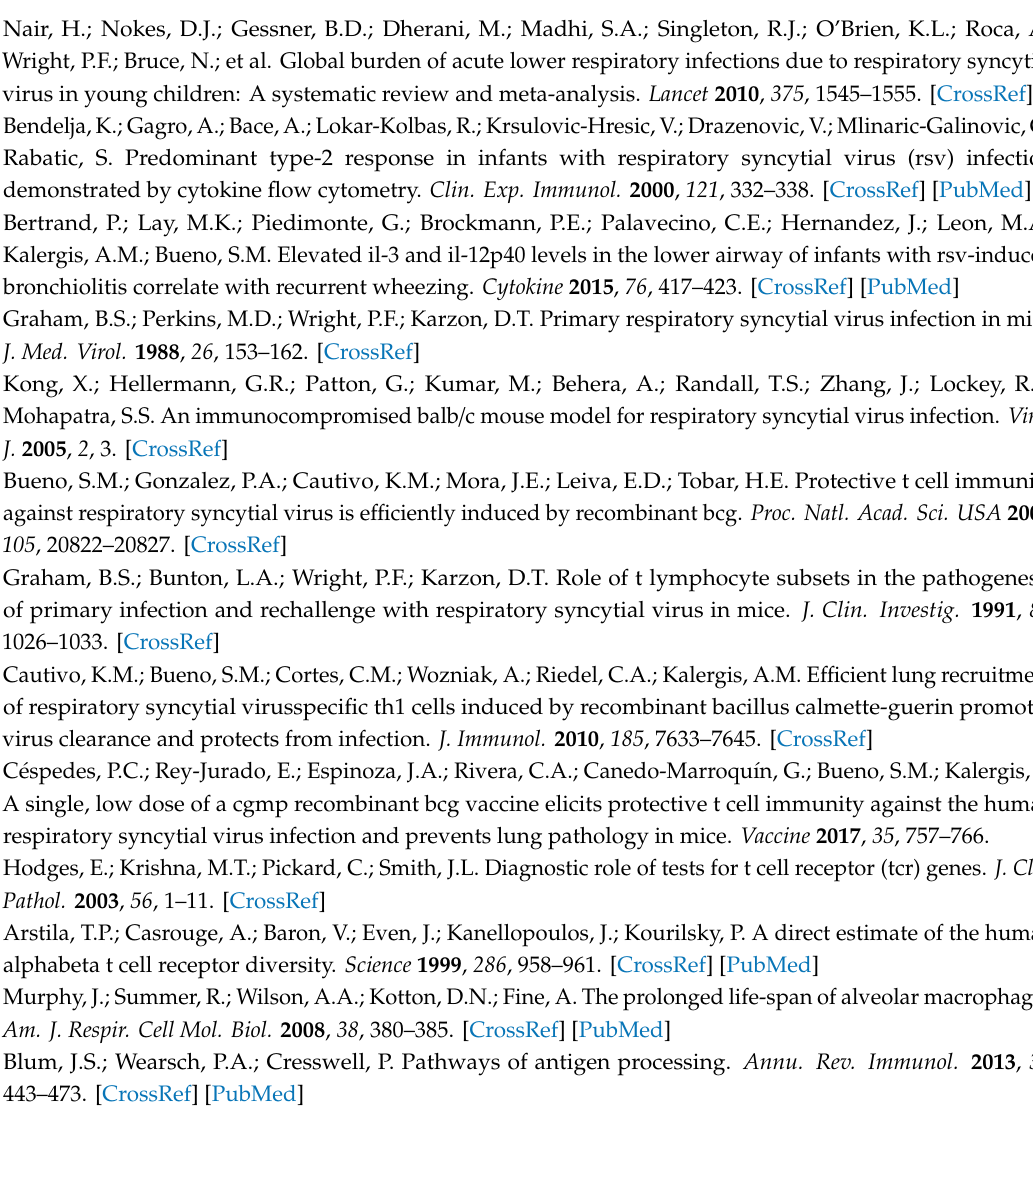
Figure S1: Gating strategy to determine the frequency of each TCRV β for hRSV-induced T